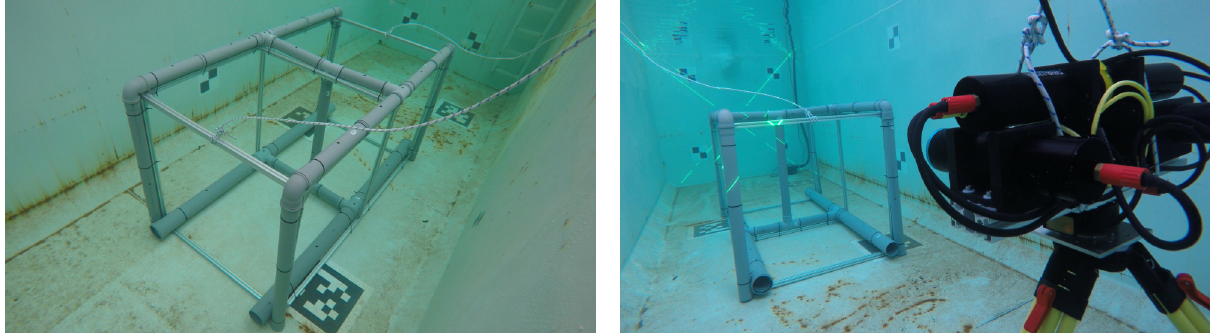
Figure 6. Scanning setup in the test tank. Left: Test structure constructed from aluminum profiles and polypropylene pipes, Right: Underwater laser scanner deployed on a tripod.